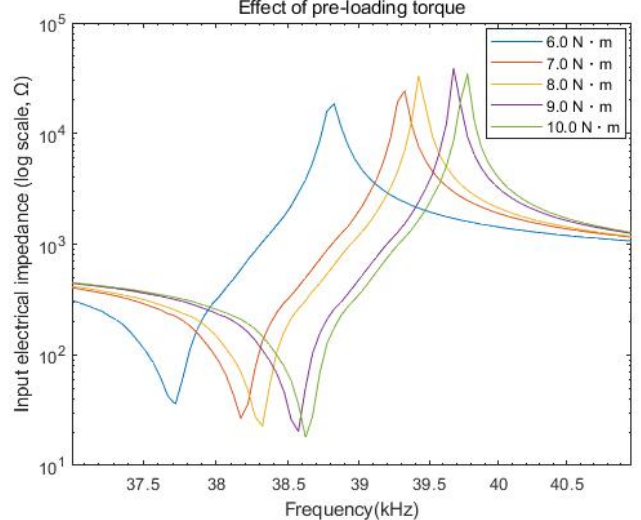
Figure 5. Frequency response of impedance as a function of pre ‐ loading torque.